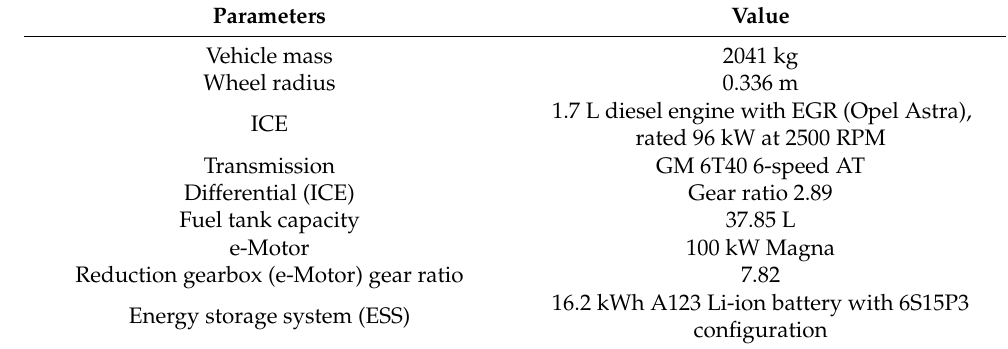
Table 1. Vehicle